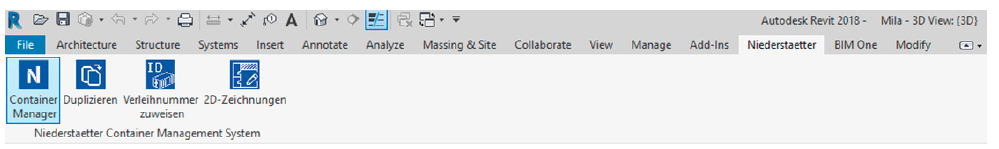
Figure 13. Algorithms in the BIM authoring user interface.